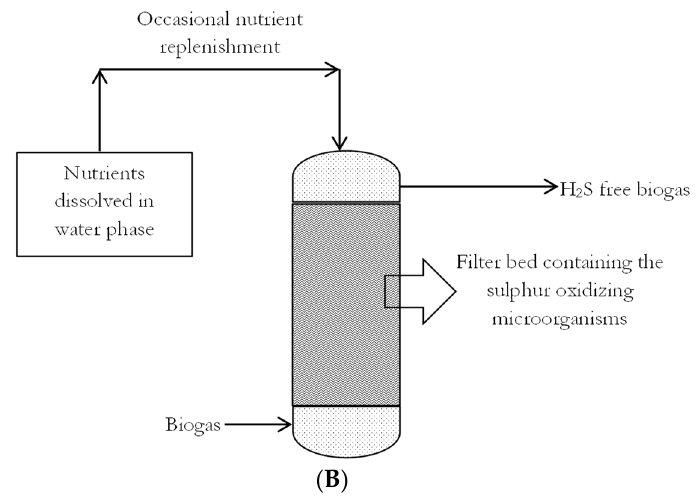
Figure 2. Simple illustration of a biotrickling filter ( A ) and a biofilter ( B ) desulphurisation set for biogas.